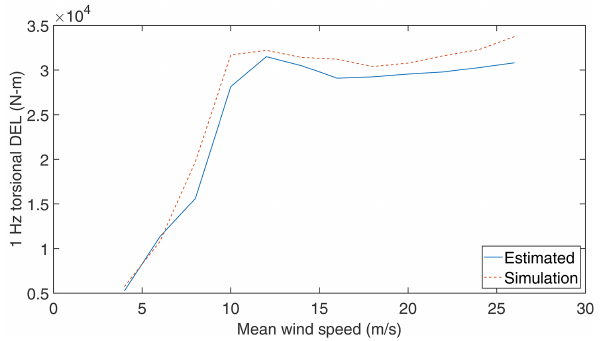
Figure 8. Comparison of the predicted DEL with the DEL com- puted from aeroelastic simulations over all mean wind